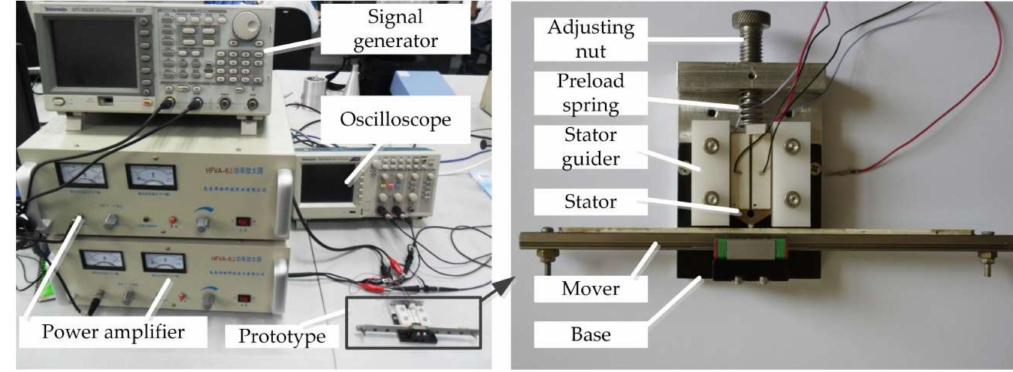
Figure 15. Experimental setup.